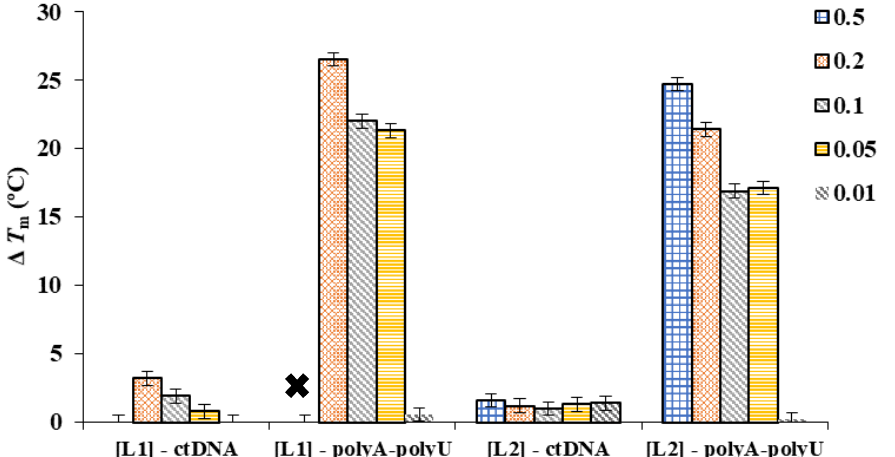
Figure 3. ∆ T m values determined for the interaction of L1 and L2 toward ctDNA and poly A-poly U at different r = [ligand]/[polynucleotide]. Each bar stands for an r value, as is described in the legend. The “ × ” indicates a ∆ T m value too high to be determined.